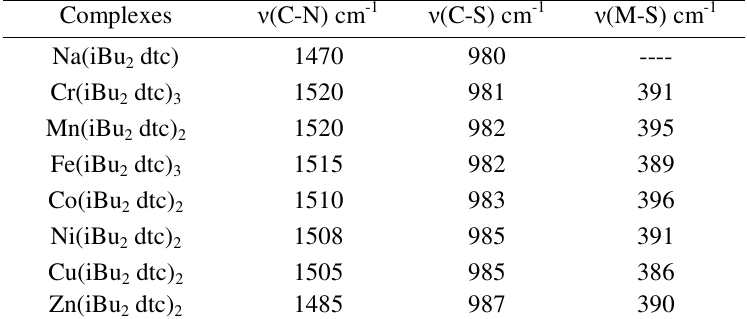
Table 2 .IR spectral data of diisobutyldithiocarbamate